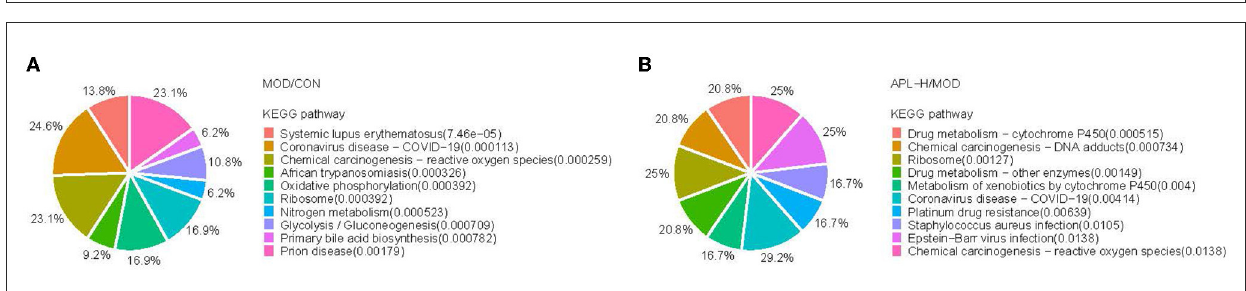
FIGURE9 KEGG analysis of the differentially expressed proteins. (A) MOD/CON; (B) APL-H/MOD.